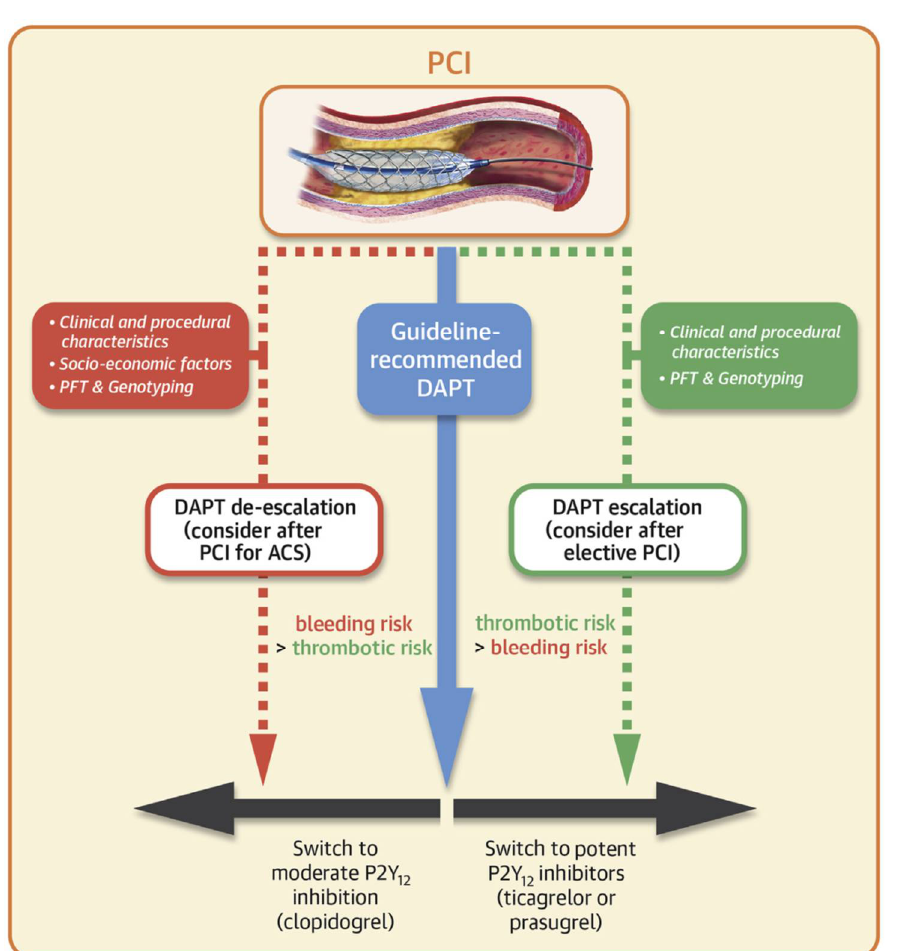
Figure 1. Considerations when implementing DAPT in relation to PCI; PFTs (such as thromboelas- tography) can guide escalation/de-escalation of therapy. Reproduced with permission from Sibbing D. et al., JACC Cardiovasc Interv 2019 [12]. ACS: acute coronary syndrome; DAPT: dual antiplatelet therapy; PCI: percutaneous coronary intervention; PFT: platelet function tests.